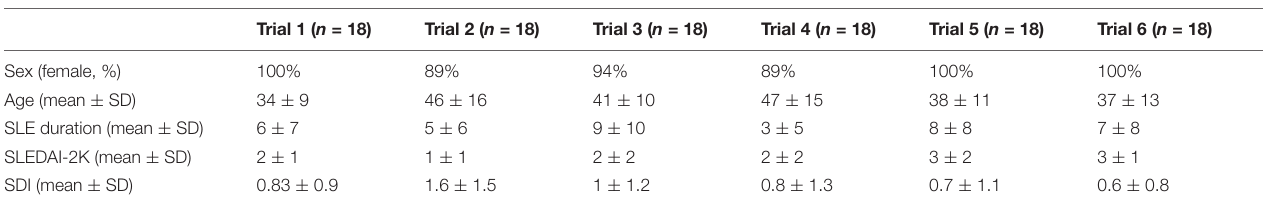
TABLE 1C | Patient population characteristics for the six test sets.